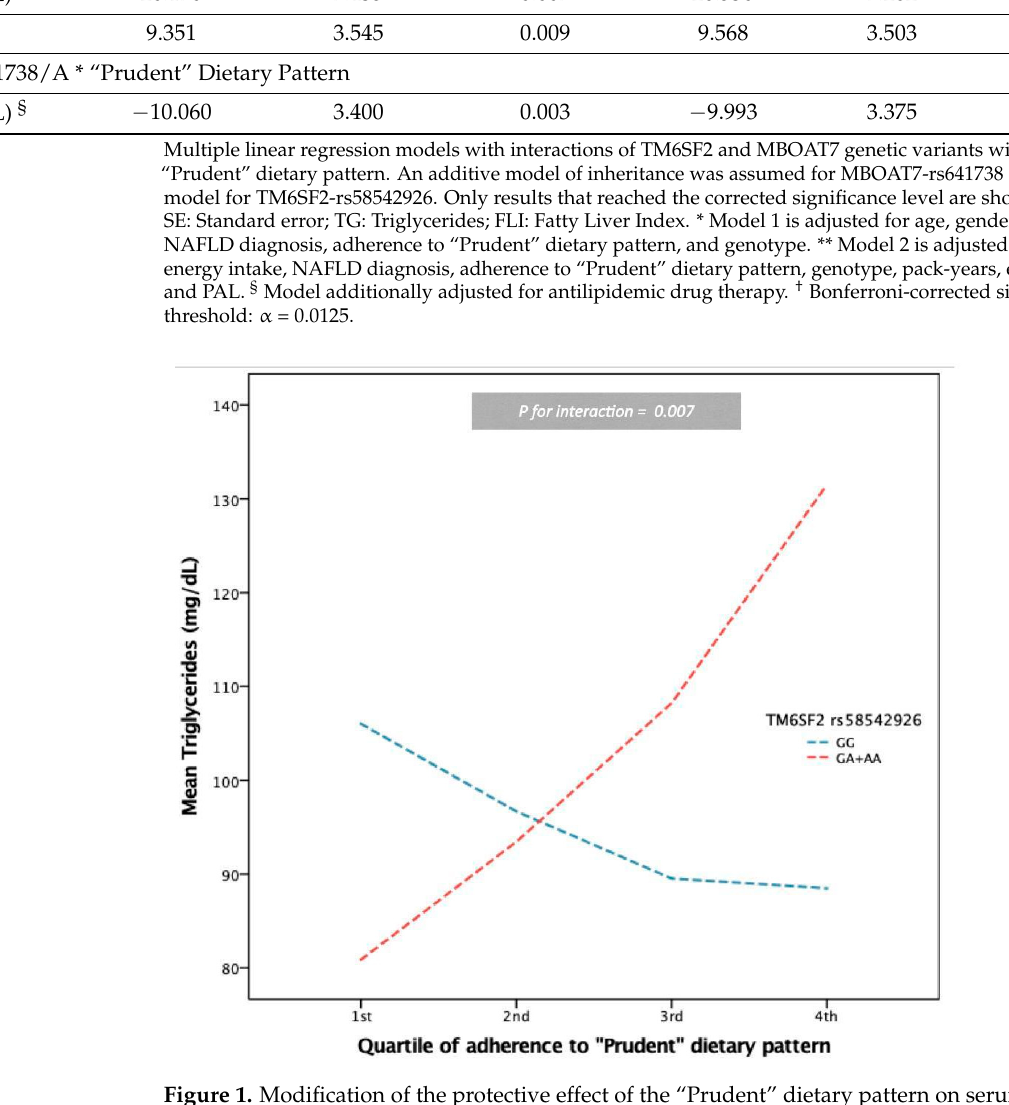
Figure 1. Modification of the protective effect of the “Prudent” dietary pattern on serum triglyceride levels by TM6SF2-rs5854292. Carrying the A allele increased triglycerides by 20.170 mg/dL when adherence to the dietary pattern was higher, compared to non-carriers and after adjusting for age, gender, energy intake, NAFLD diagnosis, adherence to “Prudent” dietary pattern, and genotype ( p interaction = 0.007). Interaction remained significant after further adjustment for pack-years, education years, and PAL. Bonferroni-corrected significance level threshold: α = 0.0125. Pairwise comparisons indicated significant differences within the 4th quartile of adherence.